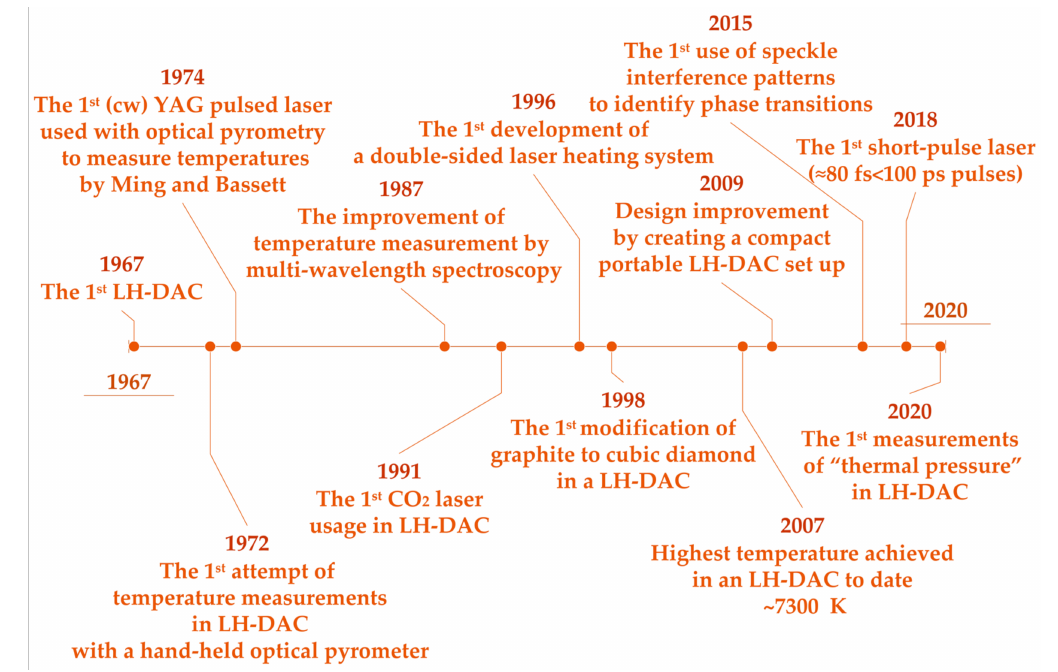
Figure 8. Chronology of Key Events in Laser-Heated Diamond Anvil Cell (LH-DAC)